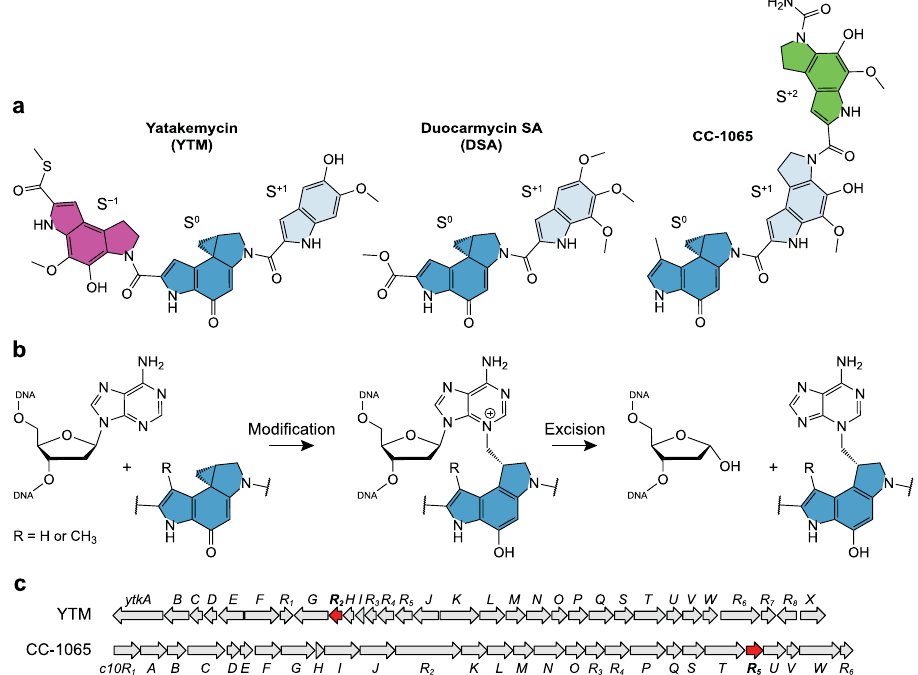
Fig. 1 DNA modi fi cation by the spirocyclopropylcyclohexadienone (SCPCHD) family of natural products. a Chemical structures of yatakemycin (YTM), duocarmycin SA (DSA), and CC-1065. All three compounds share the S 0 subunit (dark cyan), which includes the reactive SCPCHD moiety, and the S + 1 subunit (pale cyan). YTM and CC-1065 also possess the additional subunits S − 1 (magenta) and S + 2 (green), respectively, on either side of the S 0 and S + 1 subunits. b Generalized mechanisms of DNA modi fi cation by SCPCHD compounds and nucleobase excision by associated DNA glycosylases. c ytk and c10 gene clusters responsible for biosynthesis of YTM and CC-1065, respectively. Genes encoding the DNA glycosylases YtkR2 and C10R5 are colored